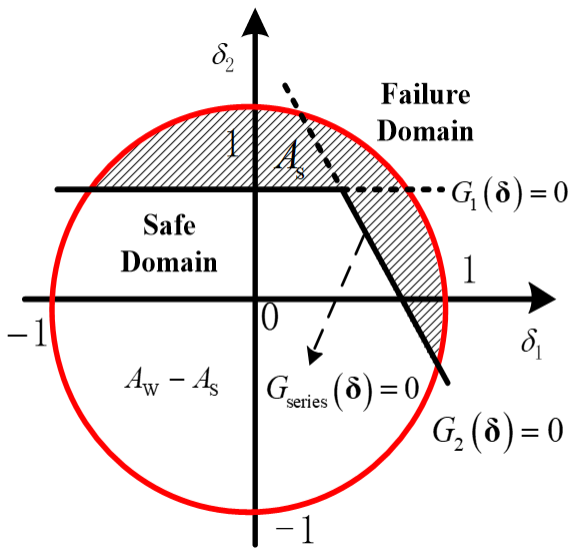
Figure 1. A series system reliability model for a two-dimensional problem.